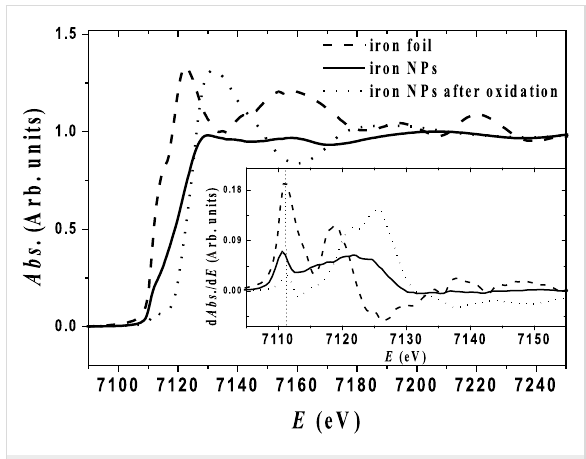
Figure 3: XANES spectra taken at room temperature for metallic Fe NPs, compared to a Fe foil reference, and intentionally oxidized Fe NPs. Inset displays the derivative of the absorption.